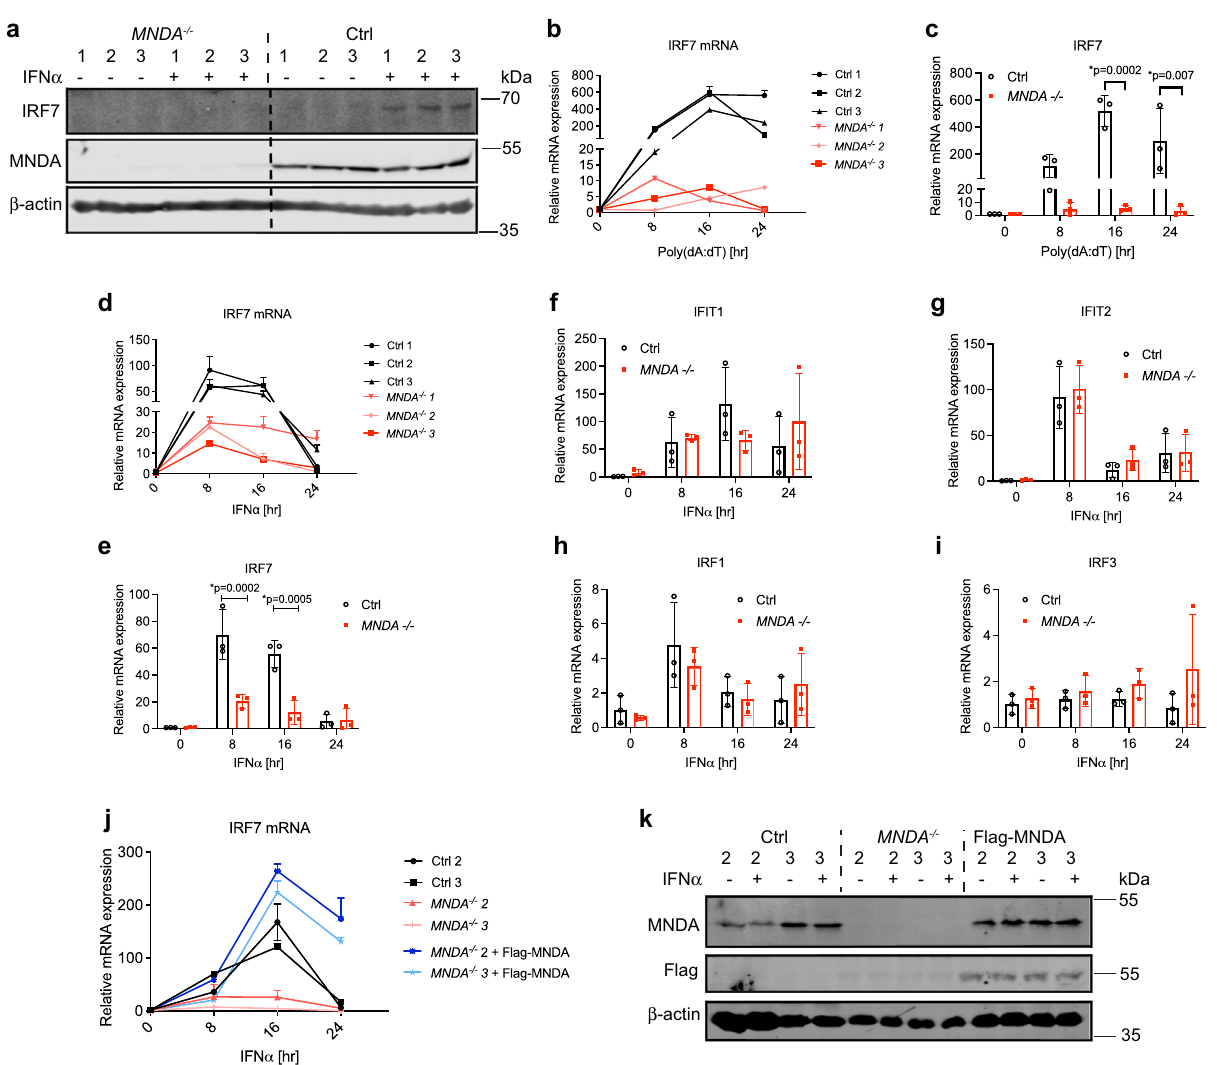
Fig. 4 Genetic ablation of MNDA impairs IRF7 mRNA induction. a Immunoblot analysis of IRF7 and MNDA protein expression in three MNDA − / − or three control THP-1 clones. b – e Three clones of MNDA − / − or control (Ctrl) THP-1 cells were transfected with 2.5 μ g/ml poly(dA:dT) ( b , c ) or treated with 1000 U/ml IFN α ( d , e ) or for the indicated times. Quantitative PCR analysis of IRF7 mRNA shown for individual clones ( b , d ) or mean of all clones ( c , e ). f – i Quantitative PCR analysis of mRNA expression of IFIT1 ( f ), IFIT2 ( g ), IRF1 ( h ) or IRF3 ( i ) in MNDA − / − or control THP-1 cells. Data shown is mean of three clones. j , k Flag-MNDA was reconstituted into MNDA − / − clone 2 and 3 by lentiviral transduction. Control cells (Ctrl), MNDA − / − cells expressing empty lentiviral vector or vector encoding Flag-MNDA were stimulated with IFN α (1000 U/ml) for the indicated times. j Quantitative PCR analysis of IRF7 mRNA. k Immunoblot analysis of Flag MNDA and MNDA protein after 24 h IFN α stimulation. All data are mean ± SD of triplicate samples and are representative of three independent experiments; two tailed unpaired Students t test; * p < 0.05 indicates signi fi cance compared to respective groups. Immunoblots ( a , k ) are representative of three